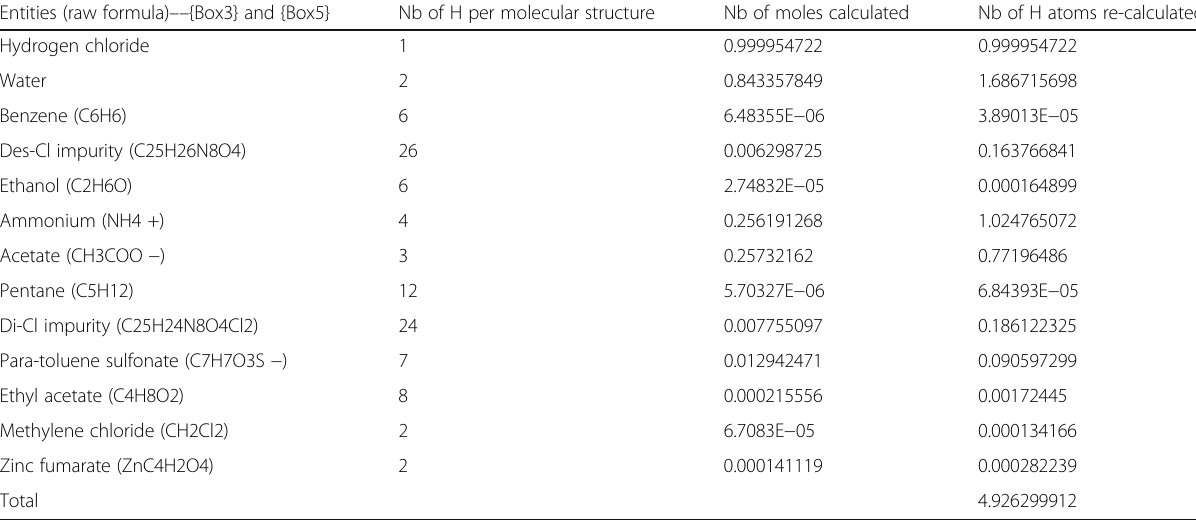
Table 1 Protons added in the complete molecular structure Entities (raw formula) –– {Box3} and